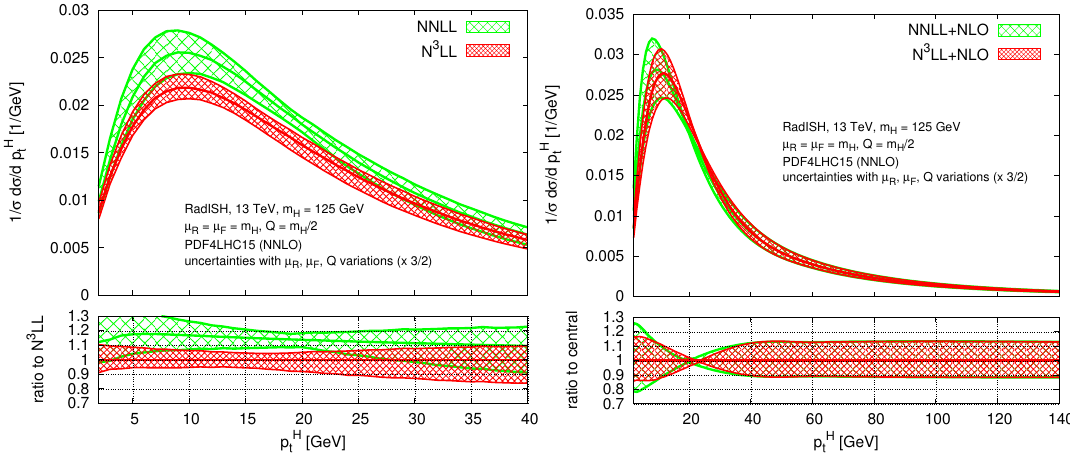
Figure 3 . Left: comparison between the resummed distributions at N 3 LL and NNLL; the lower panel shows the ratio of the two distributions. Right: comparison between the matched N 3 LL+NLO and the NNLL+NLO predictions for the inclusive Higgs spectrum; the lower panel shows the ratio of each distribution to its central